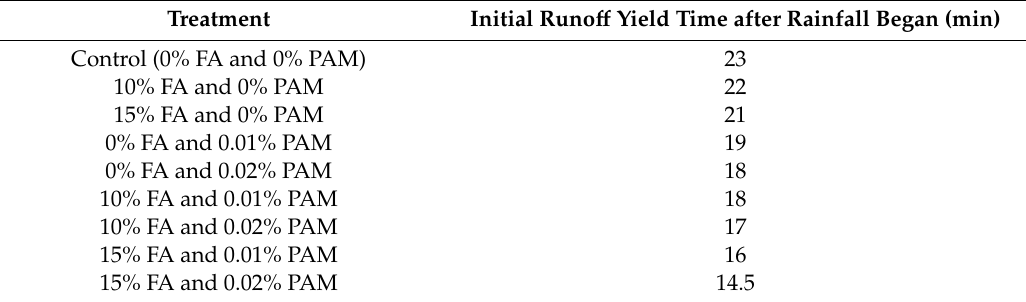
Figure 2. Changes in instantaneous runoff intensity with rainfall duration for different treatments. The error bars represent one standard deviation ( n = 3). Table 1. Initial runoff yield time in different treatments.